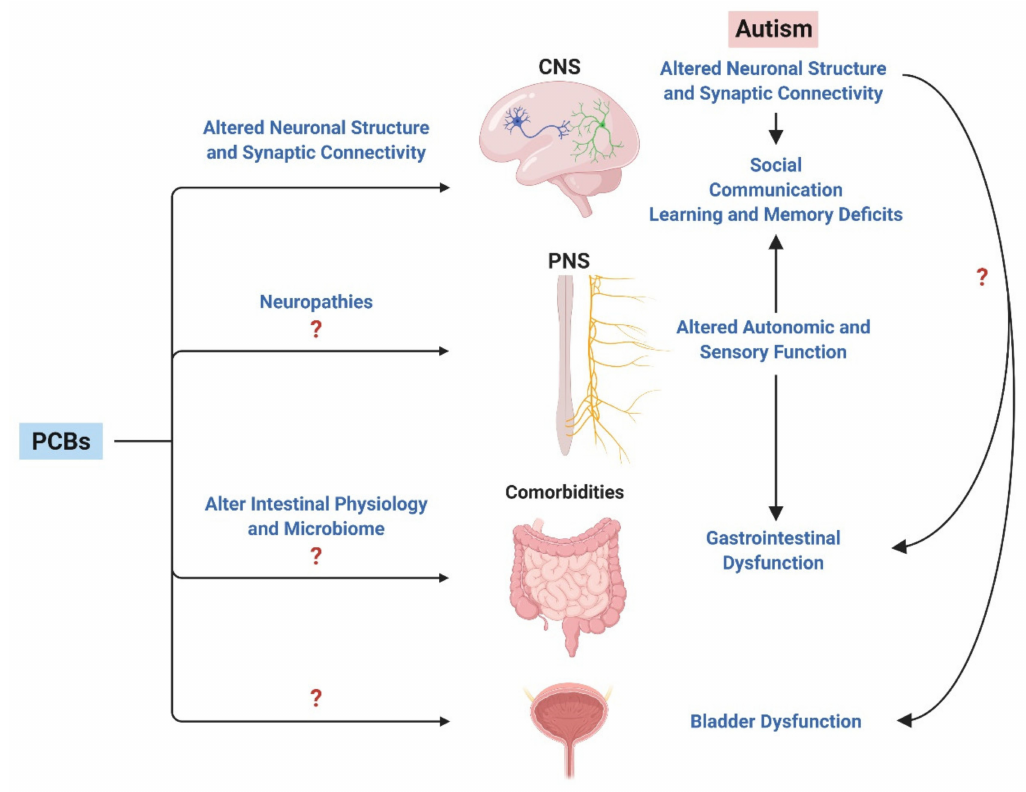
Figure 4. Links between PCBs and ASD. Developmental PCB exposure has been linked to altered neuronal connectivity in the central nervous system (CNS), an endpoint that is also disrupted in ASD. Growing evidence supports the involvement of the peripheral nervous system (PNS) in the behavioral deficits observed in ASD as well as comorbidities such as gastrointestinal (GI) dysfunction. The direct e ff ects of PCBs on the PNS, GI tract and other organs, such as the bladder, are understudied, but elucidating the impact of PCBs on peripheral targets may help to explain the clinical heterogeneity that is a hallmark of ASD. Created with